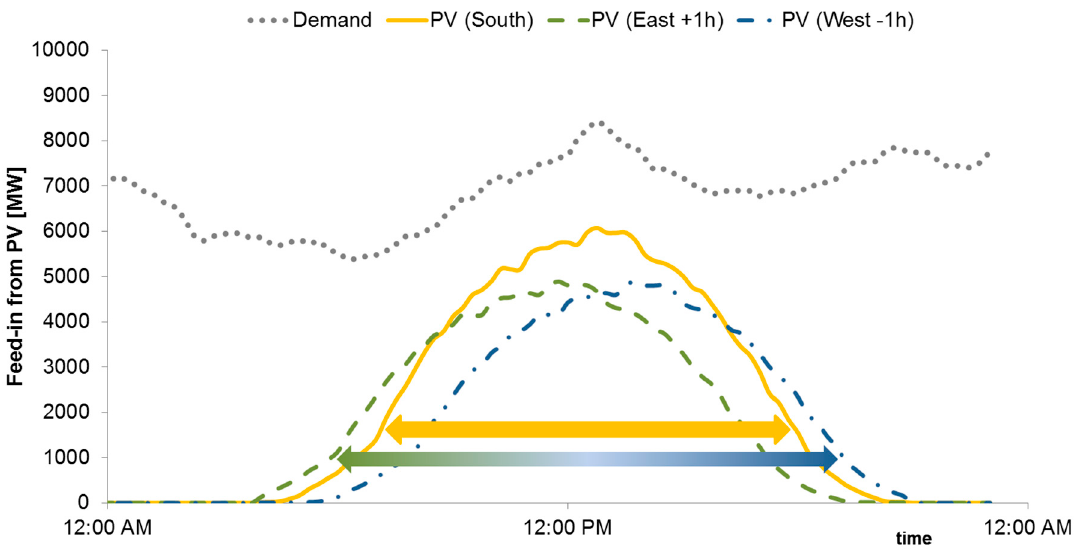
Figure 2. Comparison of normalized baseline feed-in (PV(S) vs. modified advanced feed-in PV (E) and PV (W) installations over 24 h.